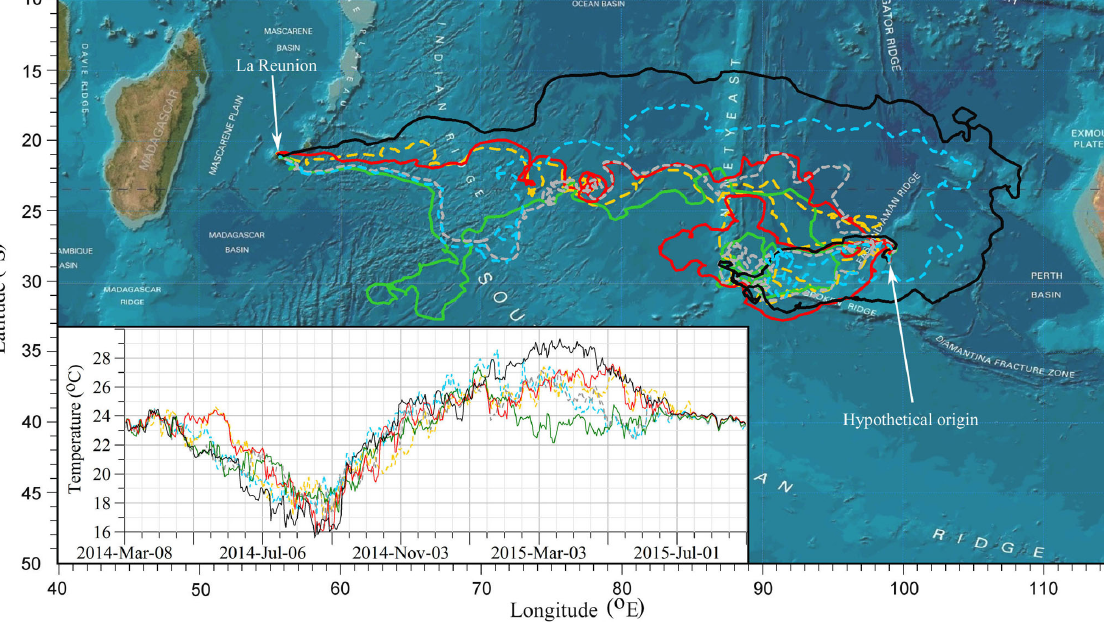
Figure 8. Sample tracks and temperatures for the six particles of ensemble no. 23 (leeway 3.29%; drift angle 18 ◦